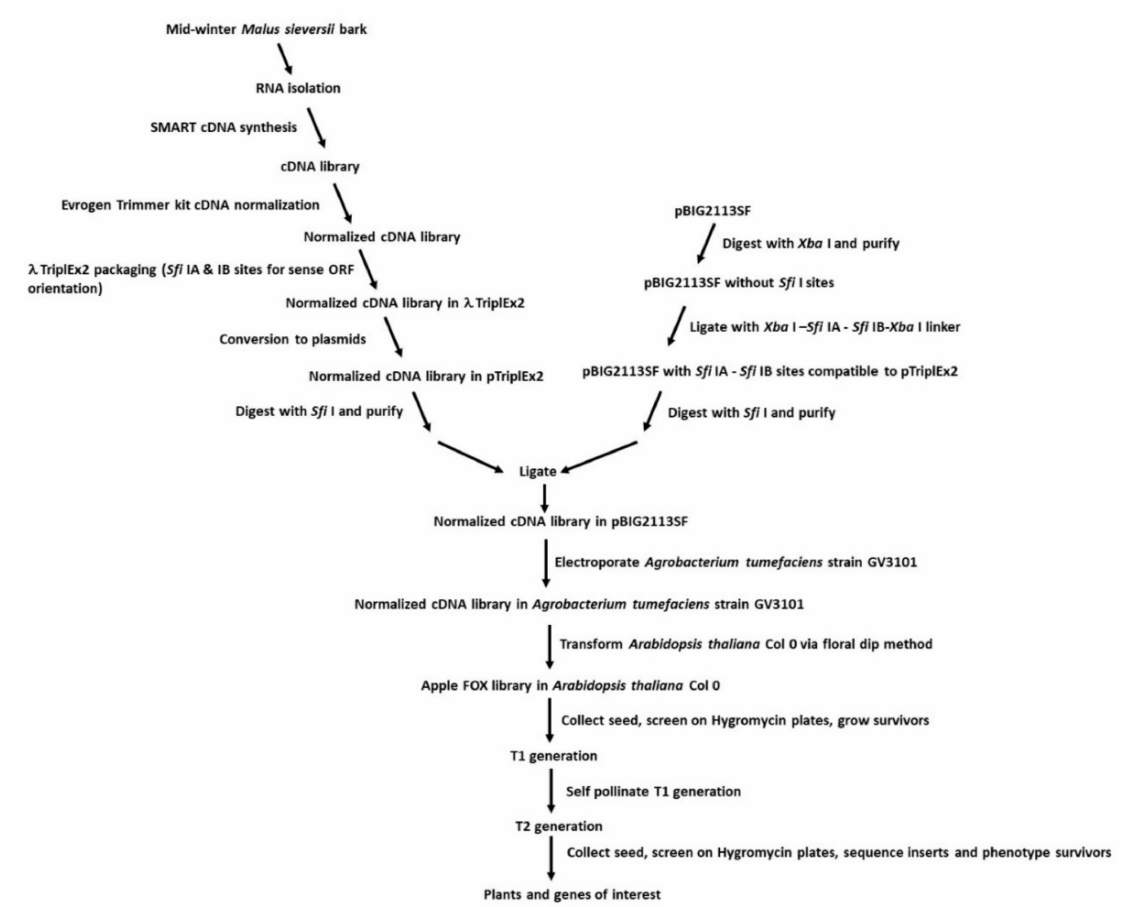
Figure 5. Schematic of M. sieversii FL-cDNA, FL-cDNA expression, and FOX Arabidopsis library